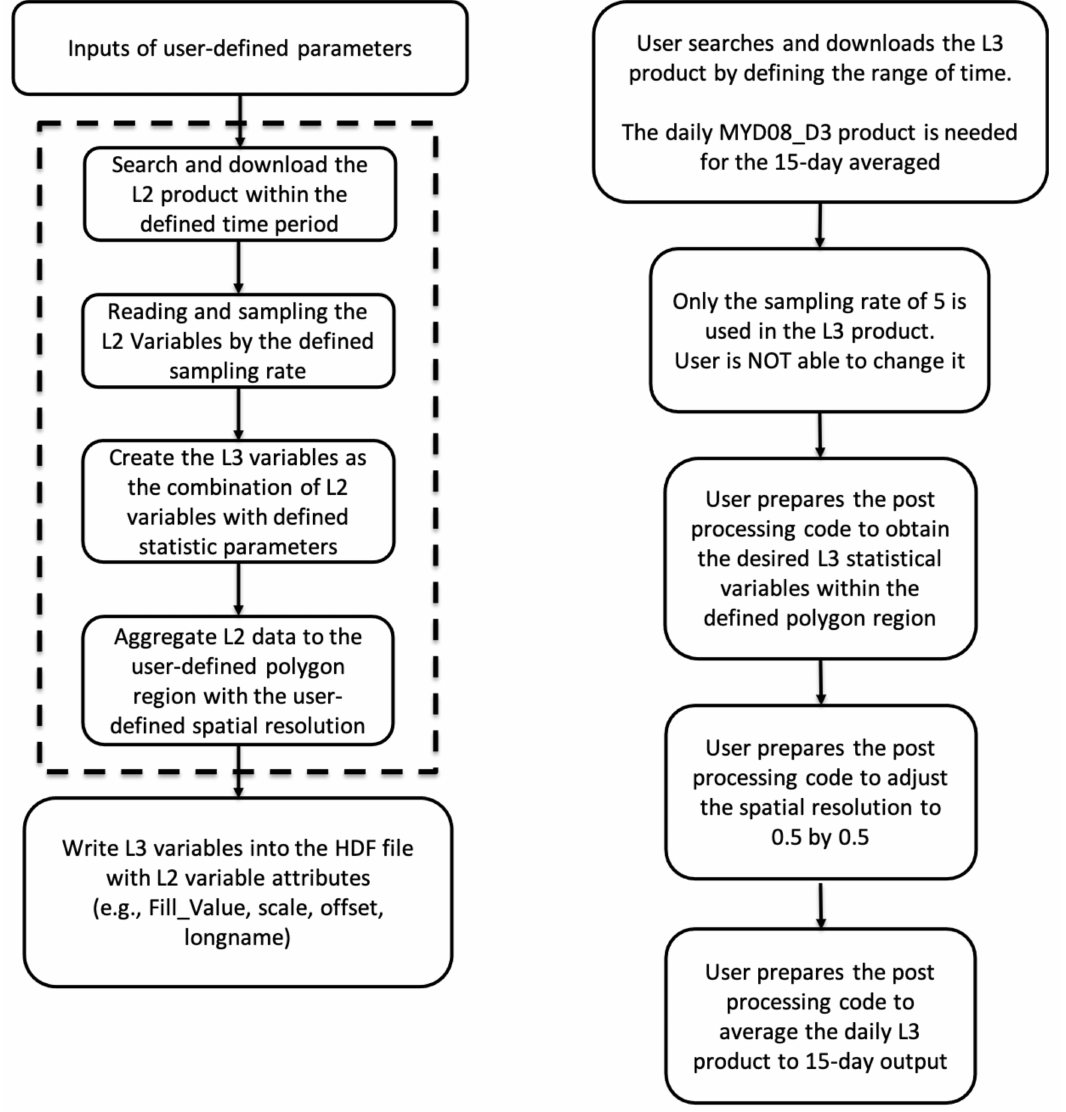
Figure 5. The flow chart of the aggregation on the desired cloud top temperature by using the flexible aggregation framework ( left ) and the current L3 product ( right ). The dashed box indicates the internal process in the python-based flexible aggregation